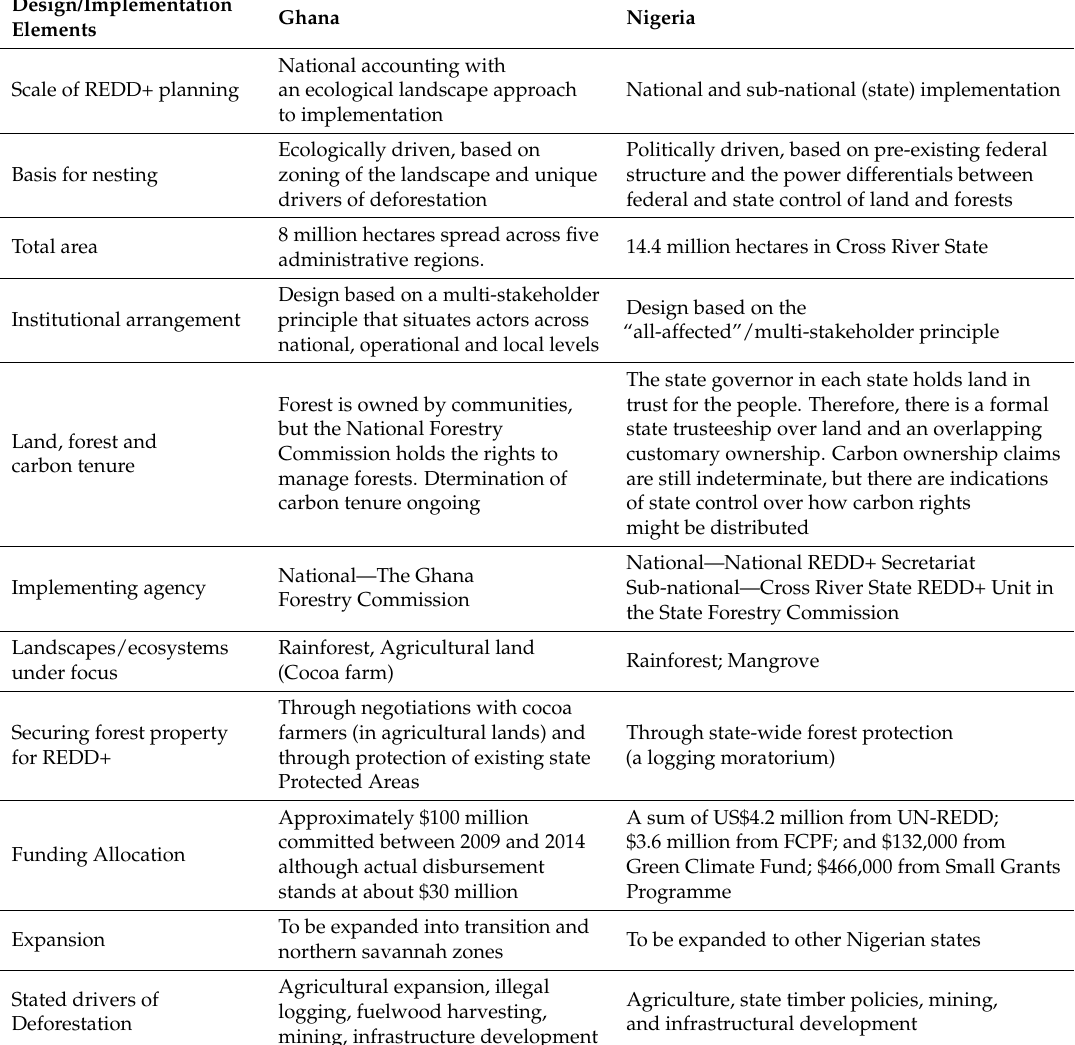
Table 1. Characteristics of REDD+ in Ghana and